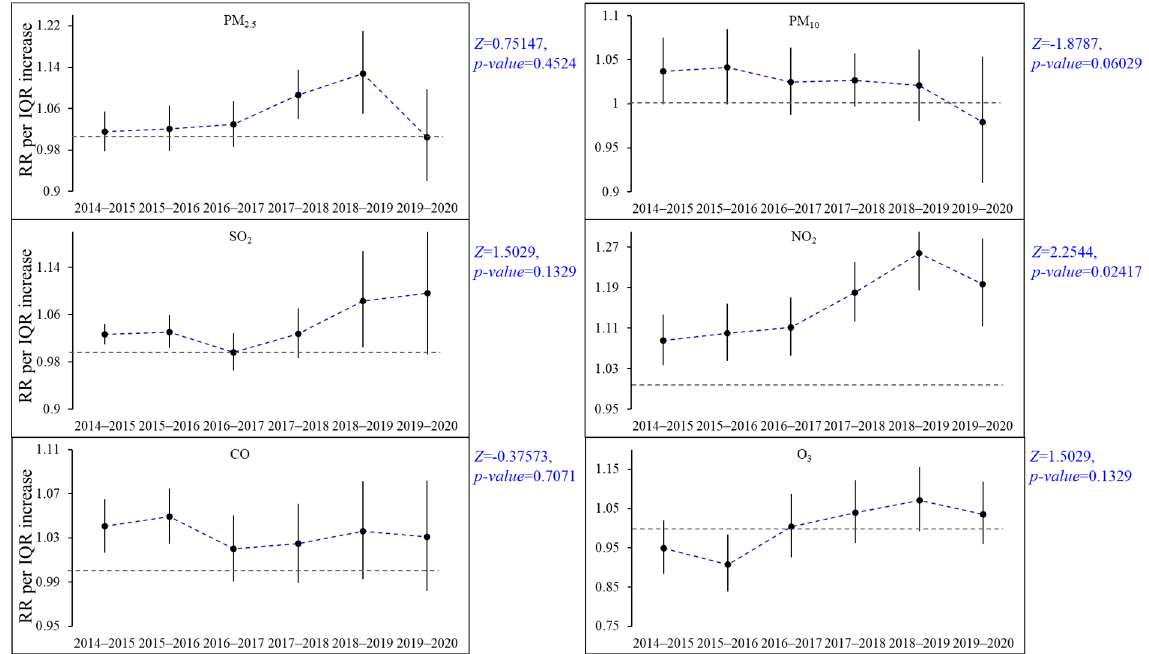
Figure 3. Relative risks (RRs) of AR visits for an IQR increase of air pollutants at lag0 in the period- specific analysis of overlapping 2-year intervals. The dotted curve lines indicate the trend of the mean risk estimate. Note: Z and p -values indicate the results of the Mann–Kendall test.